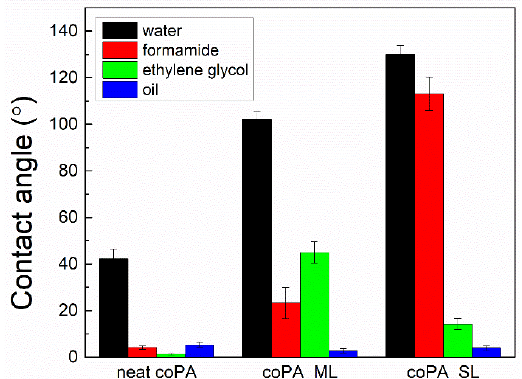
Figure 6. Contact angles for different solvents on the coPA, coPA/ML-Ti 3 C 2 T x , and coPA/SL-Ti 3 C 2 T x